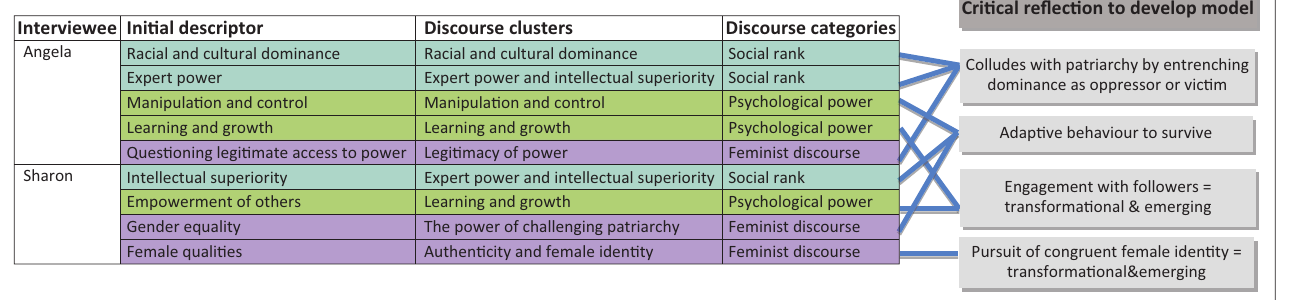
FIGURE 1: Integrating analysis method – Objective one: How women narrate awareness of